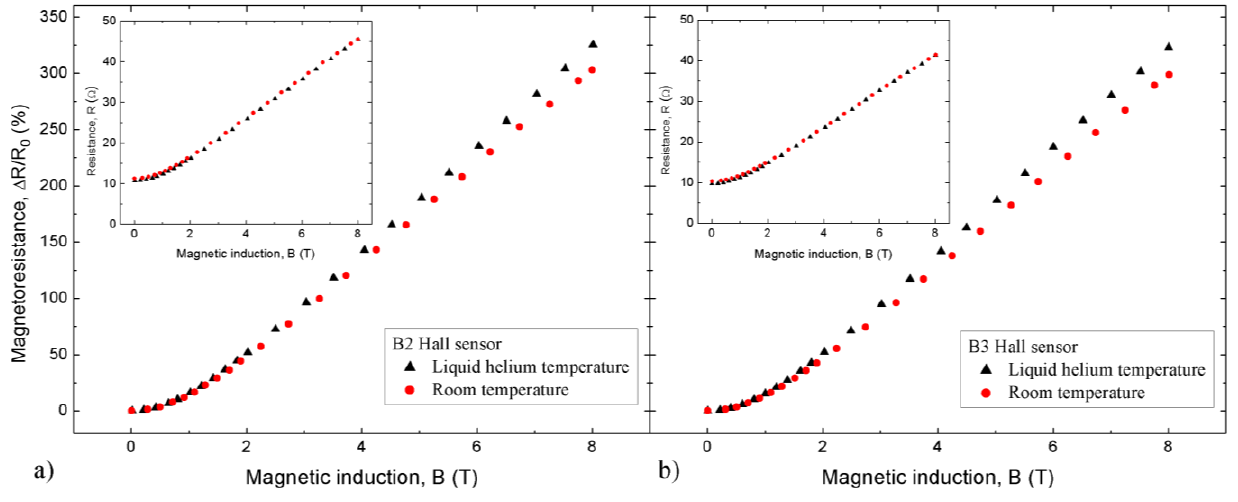
Figure 5. Field dependence of relative magnetoresistance Δ R / R at 20 °C and −269 °C for sensors B2 and B3. This dependence was obtained from the measured dependence R ( B ) shown in